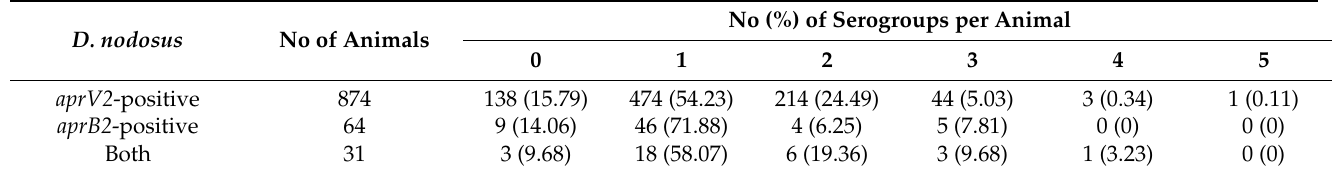
Table 2. Number (No) and percentage of serogroups per animal by aprV2 -positive strains, aprB2 - positive strains or both strains of D. nodosus . The percentages refer to the total number of animals ( n = 969) positive for the respective